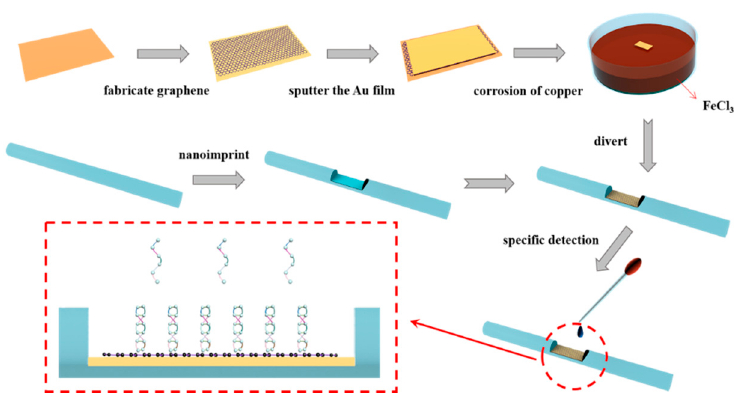
Figure 1. The schematic representation of the preparation procedure of the Au-graphene structure D-type fiber surface plasmon resonance (SPR)